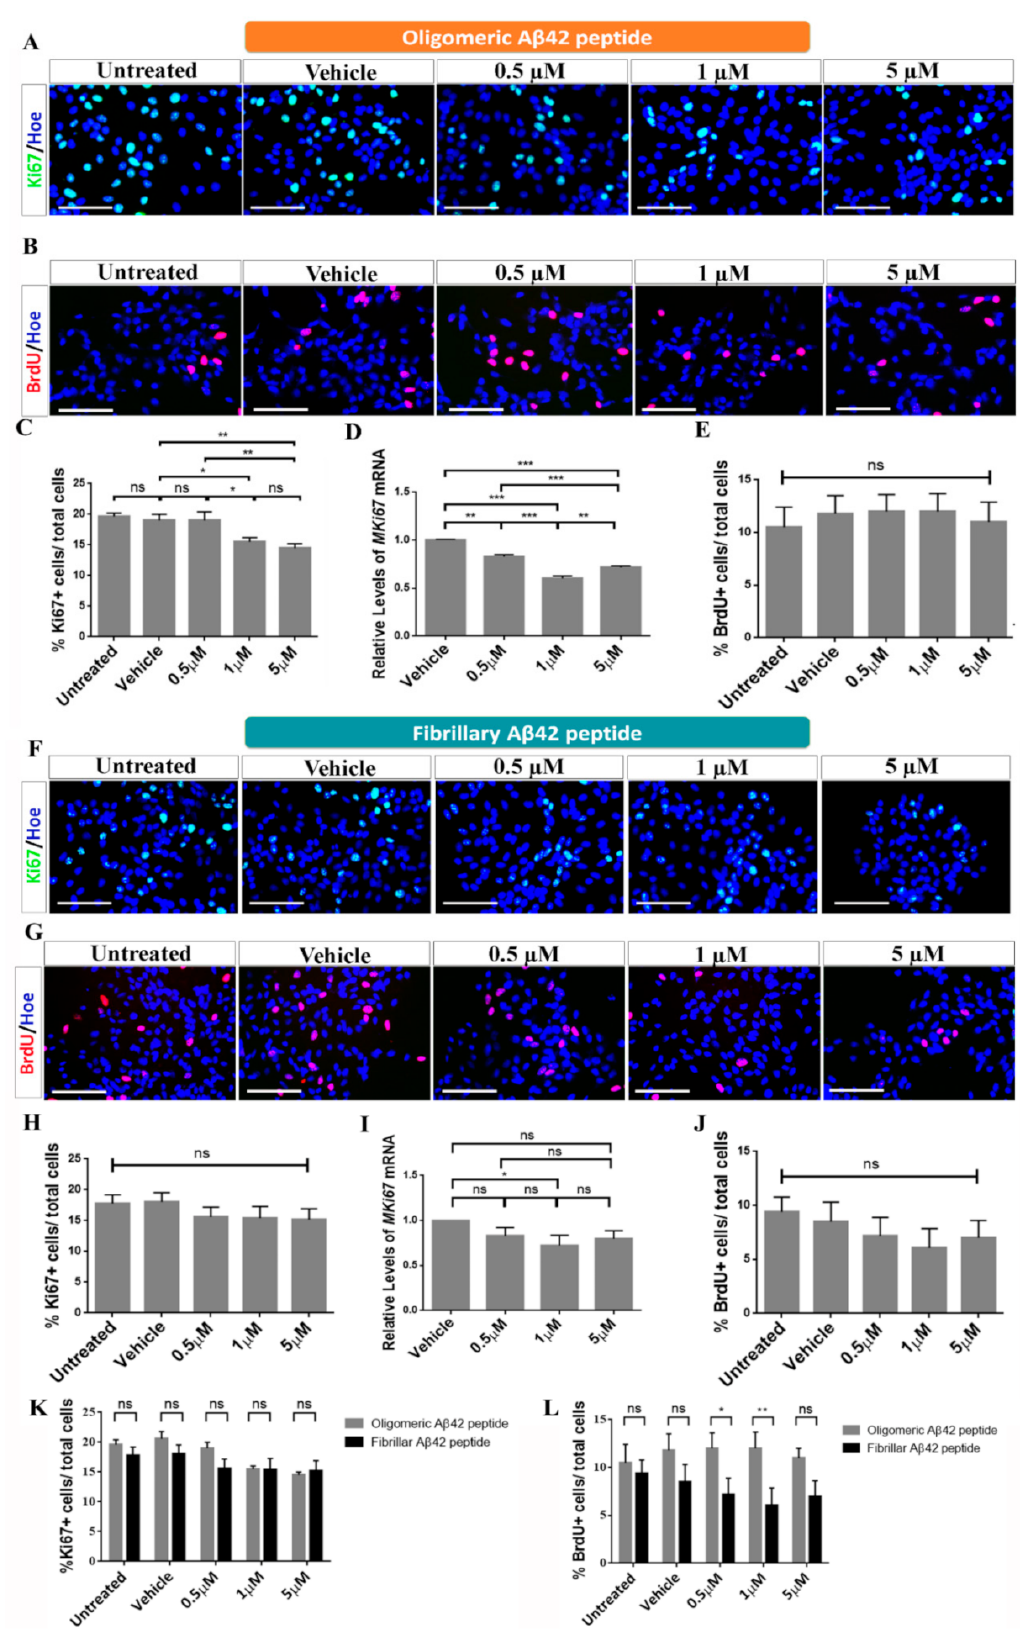
Figure 3. Oligomeric and fibrillary A β 42 affects cell cycle of differentiating hNS1 cells. ( A ) Representative images showing Ki67 immunoreactivity (green) after oligomeric A β 42 treatment. ( B ) Microphotographs with immunoreactivity for